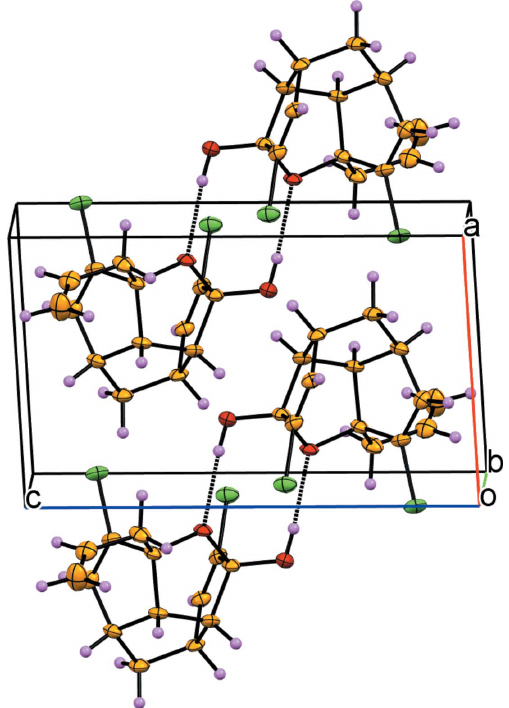
Figure 2 The crystal packing of 1 , viewed along the b- axis direction. The hydrogen bonding is shown using dotted lines.